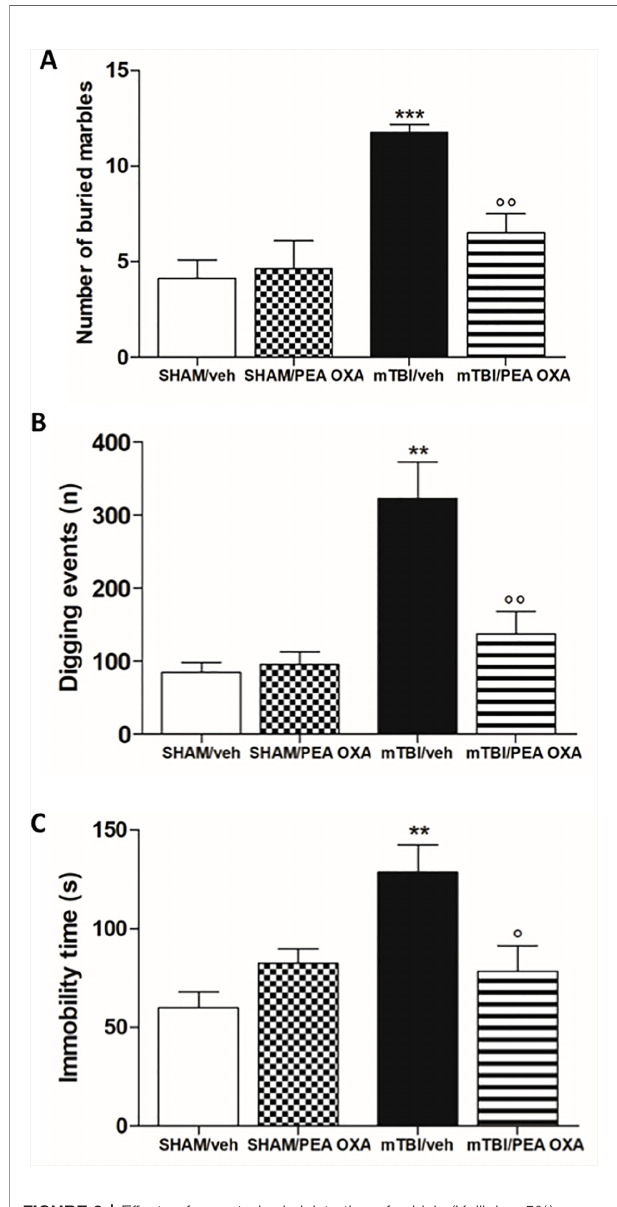
FIGURE 2 | Effects of repeated administration of vehicle (Kolliphor 5%) or PEA-OXA (10 mg/kg, i.p.) on behavioral evaluations in sham and mTBI mice. (A , B) Number of buried marbles and digging events in marble burying test, respectively (C) Duration of immobility in the tail suspension test. Data are represented as mean ± SEM of eight mice per group. **P < 0.01 and ***P < 0.001 indicate signi fi cant differences compared to SHAM/veh. °P < 0.05 and °°P < 0.01 indicate signi fi cant differences compared to TBI/veh. P < 0.05 was considered statistically signi fi cant. One-way ANOVA, followed by Bonferroni post hoc test was